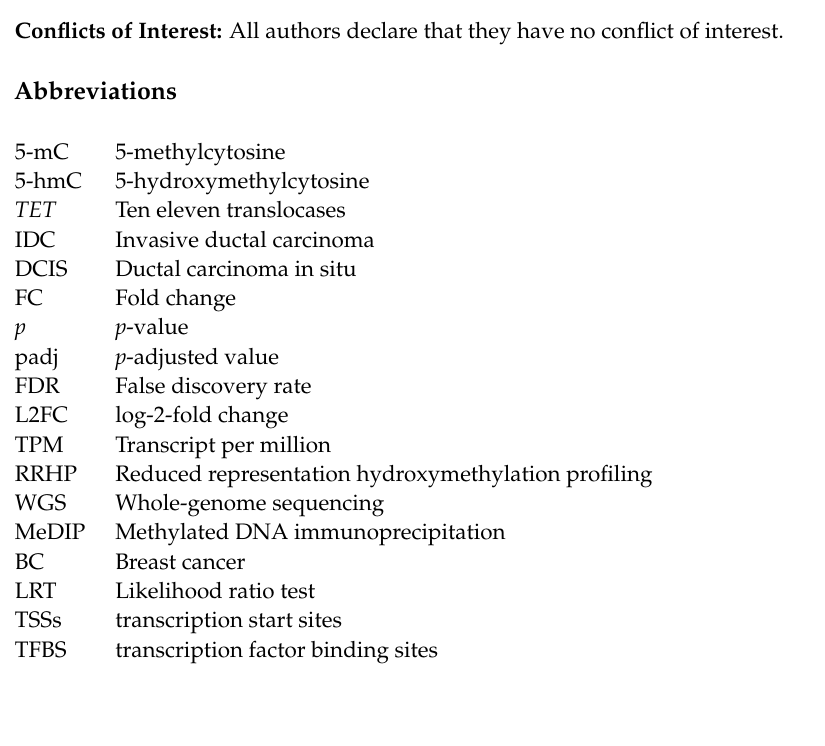
analysis using UALCAN and LOLA webtool. Figure S4: (a) KEGG pathway enrichment analysis of DMRs. (b) Gene ontology analysis of DMRs. (c) KEGG pathway enrichment analysis of DhMRs. (d) Gene ontology analysis of DhMRs. Figure S5: (a) Survival analysis of TXNL1 in breast cancer patients using UALCAN webtool. (b) Survival analysis of CNIH3 in breast cancer patients using UALCAN webtool. (c) Survival analysis of BNIPL in breast cancer patients using UALCAN webtool. File S1: (a) Significant differentially hydroxymethylated regions (DhMRs) of breast tumor and normal samples. (b) Significant differentially methylated regions (DMRs) of breast tumor and normal samples. File S2: Significant hyper- and hypo-5-mC and 5-hmC regions (a) Hyper-hmC gene list (b)